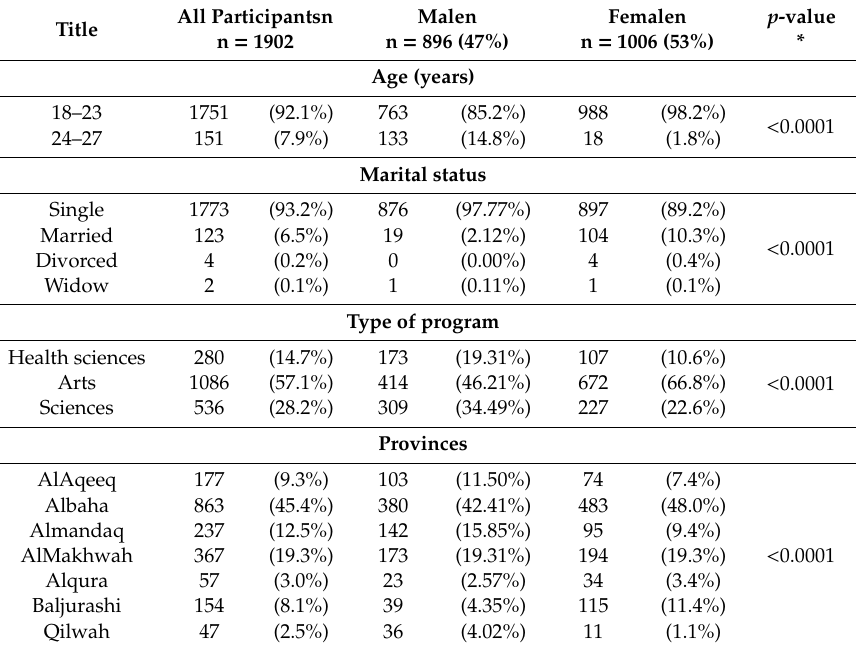
Table 1. Sociodemographic characteristics of the